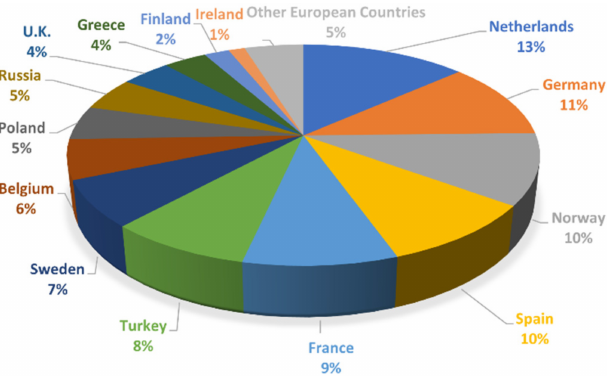
Figure 1. Percentage of new WT installations in 2020 (both on- and offshore), in terms of produced MW capacity. Based on data retrieved from